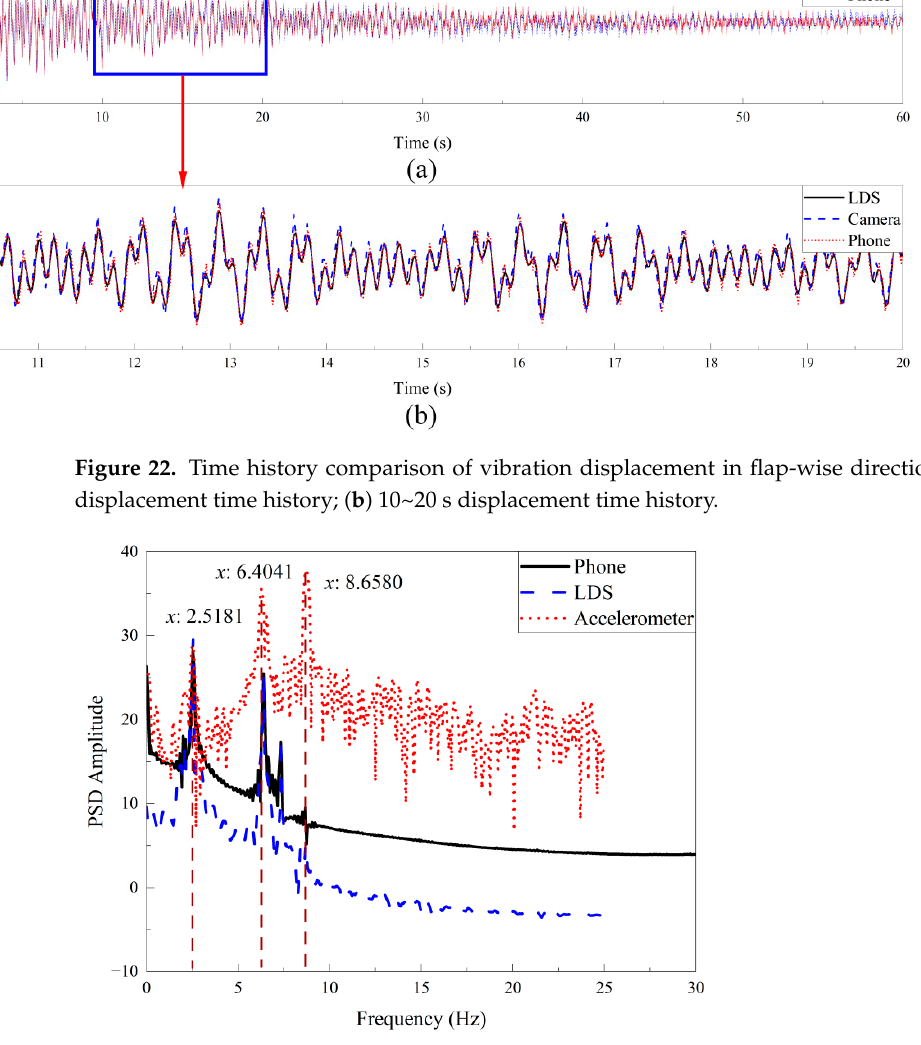
Figure 22. Time history comparison of vibration displacement in flap-wise direction: ( a ) Whole dis- placement time history; ( b ) 10~20 s displacement time history.